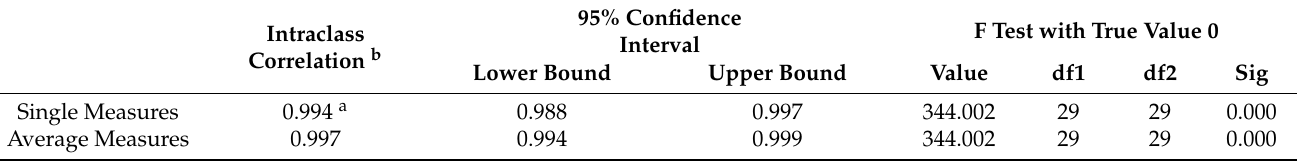
Table 4. Between-day intraclass correlation